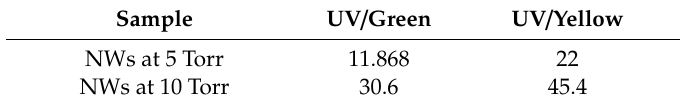
Table 2. Intensity ratio UV / visible of ZnO NWs deposited at 5 Torr and 10 Torr, respectively.